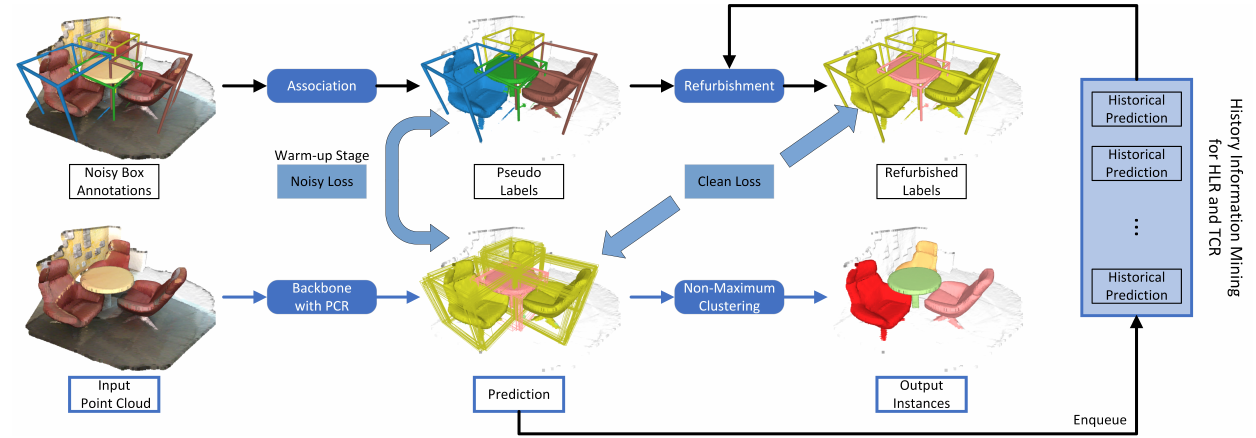
Figure 2. The training framework of self-distillation based on perturbation and history. We first generate pseudo-labels according to the point–box association (c.f. Section 3.2) and train a 3D sparse convolutional network with two types of consistency regularization, namely, PCR (c.f. Section 3.4.1) and TCR (c.f. Section 3.4.3). With the help of regularization, the model is able to perform label refurbishment (HLR, c.f. Section 3.4.2) with higher precision. Note that the noisy loss is used only in the warm-up stage, and afterward, it is replaced by the clean loss, since the cleaned (i.e., refurbished) labels are